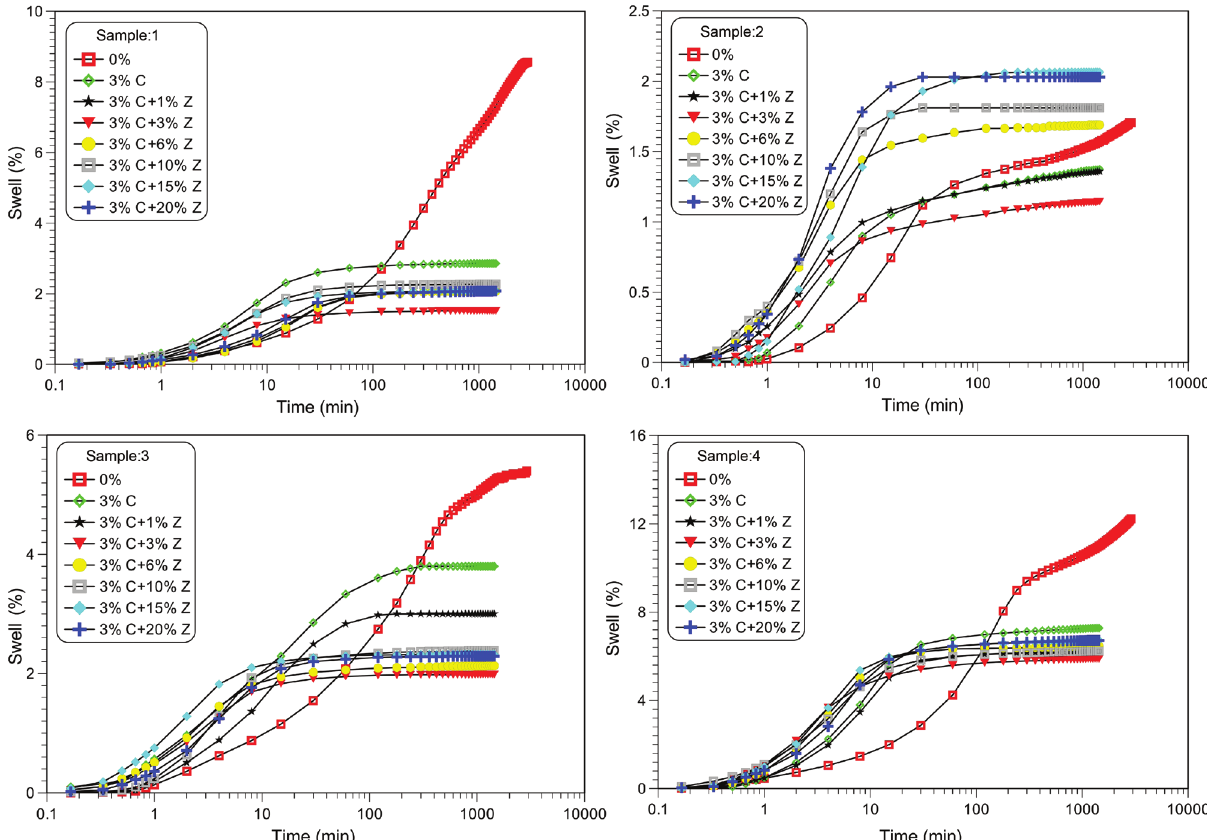
Figure 4 Swell percentage vs. time plots for the soil samples mixed with different additive